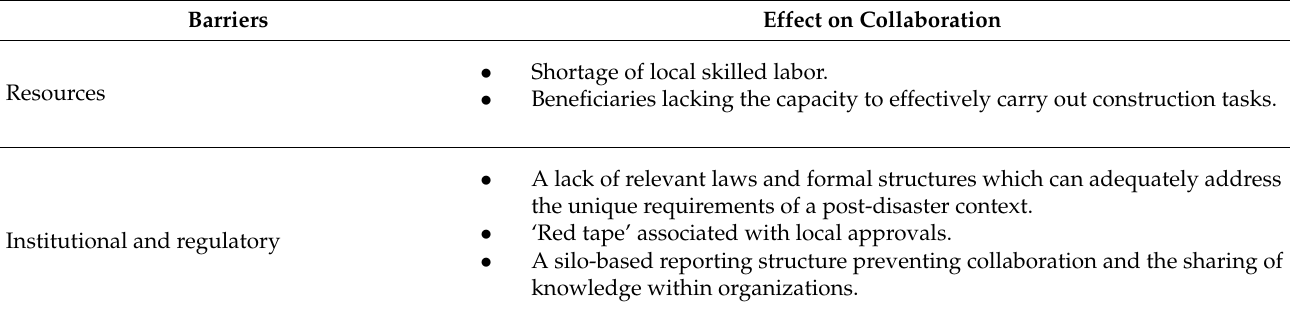
Table 1. Barriers to